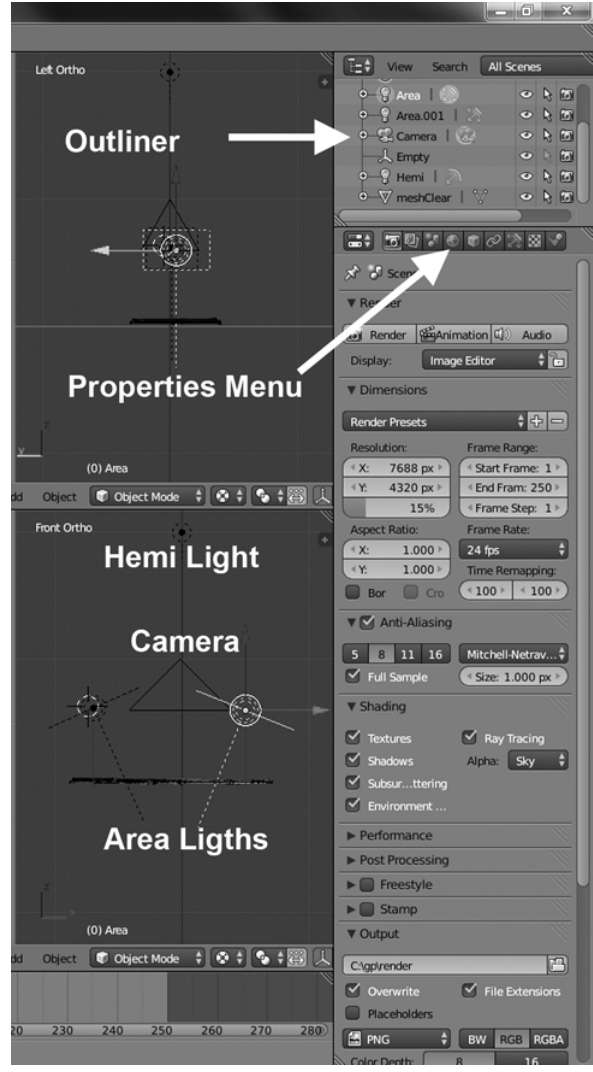
Figure 7: Rendering applying